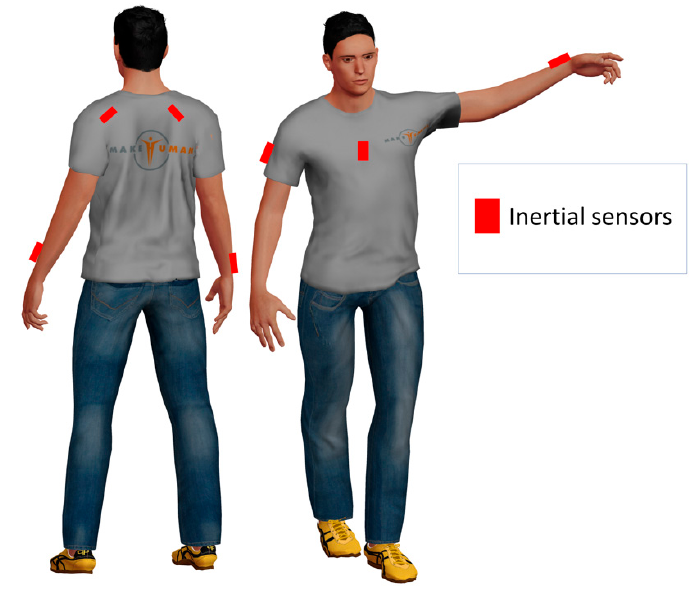
Figure 1. Exemplary application of inertial devices to monitor movements.